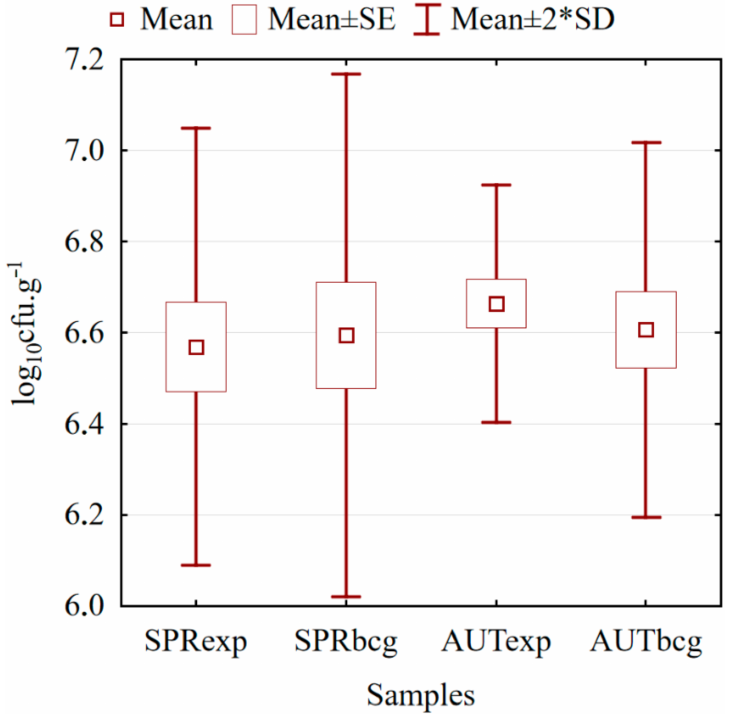
Figure 2. Average total heterotrophic bacterial count at 22 ◦ C (TVC22) values in soil samples from experimental plots and background areas. Note: * SPRexp—experimental in spring; SPRbcg— background in spring; AUTexp—experimental in autumn; AUTbcg—background in autumn.